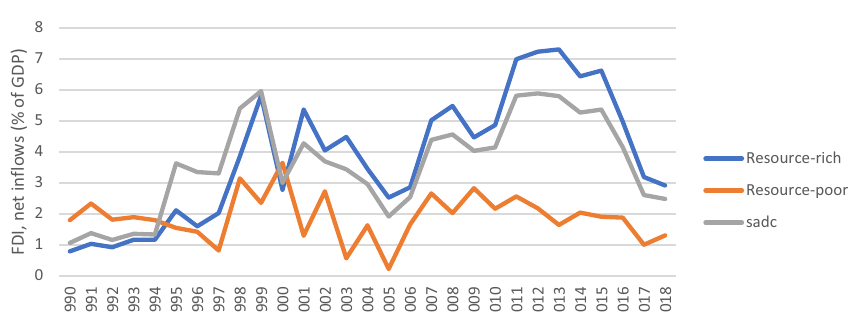
Figure 2. Trends in FDI